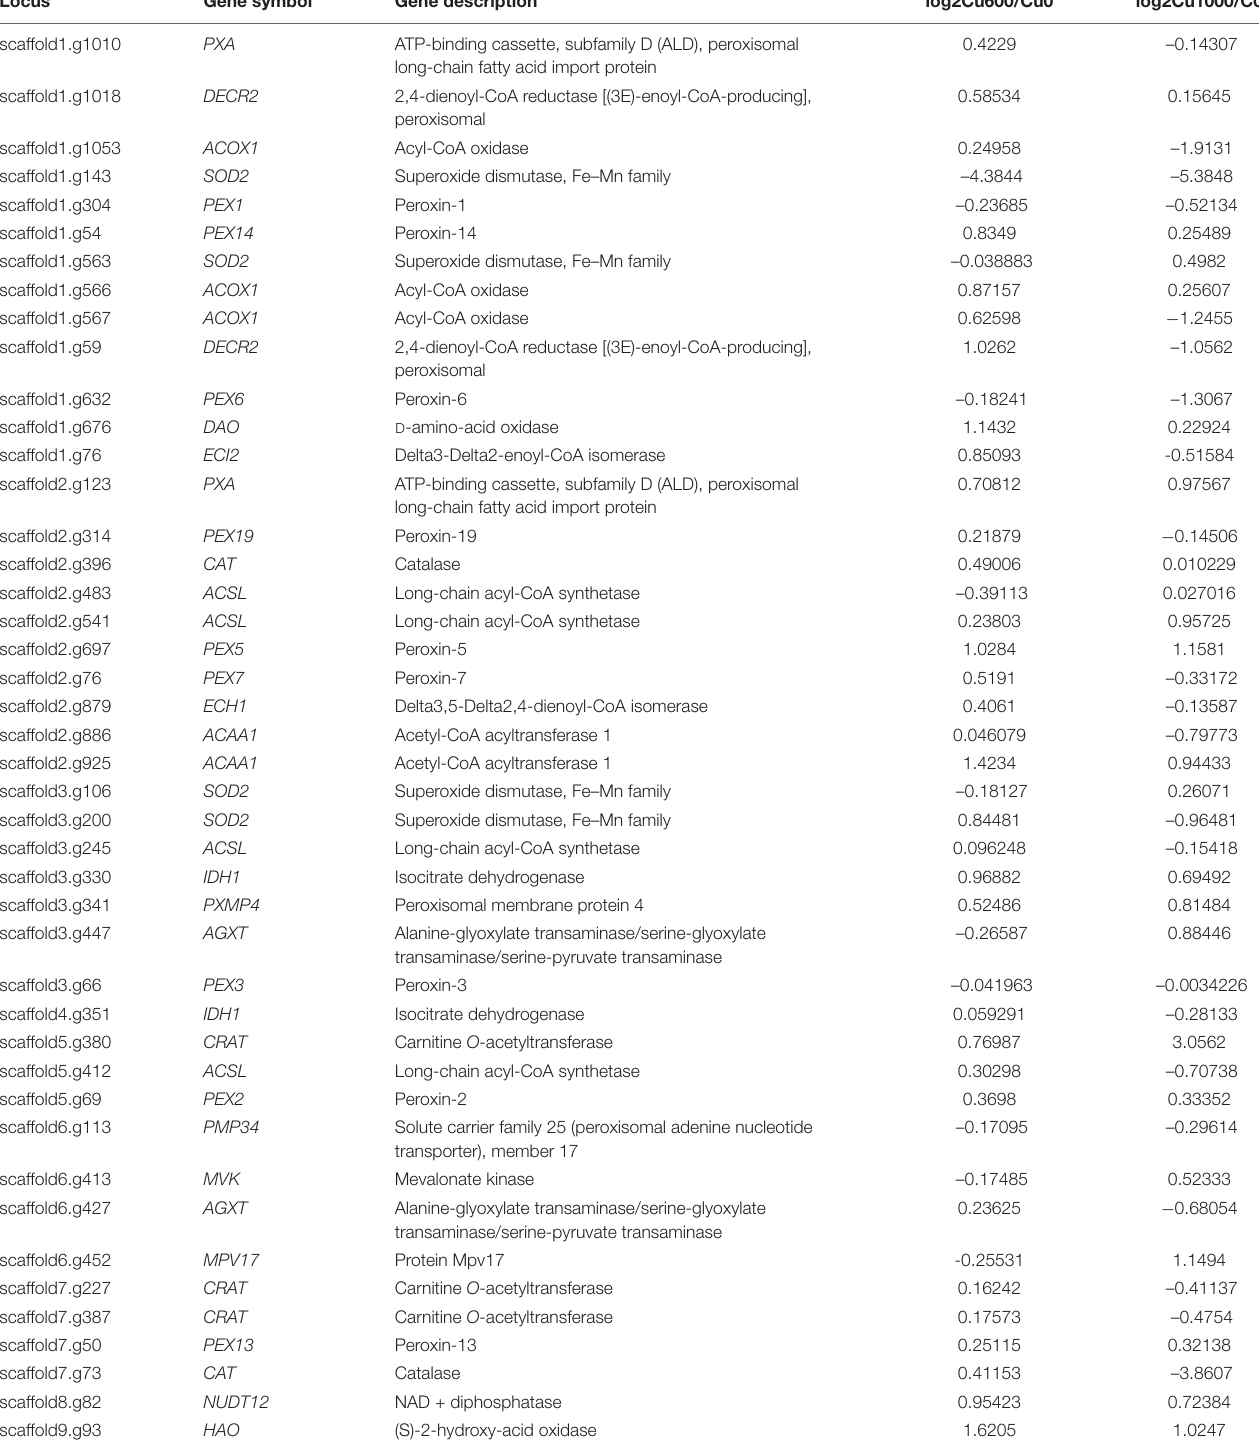
TABLE 5 | Differentially expressed genes involved in peroxisome metabolism (KEGG: pgu01230) in the Cu-600 and Cu-1000 groups. Locus Gene